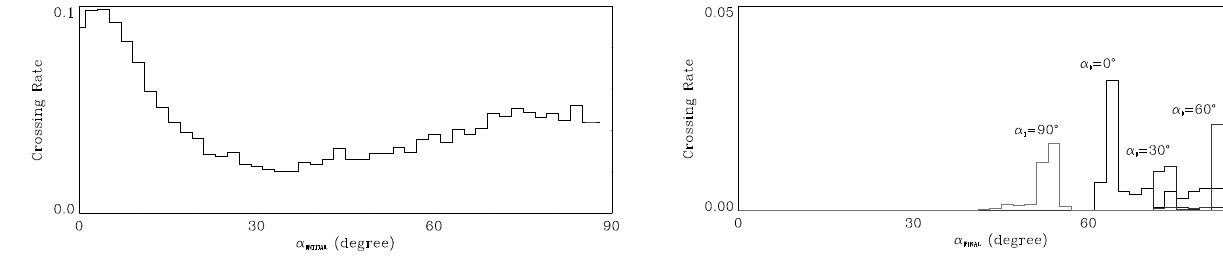
Fig. 6. Number of escaping particles depending on initial pitch- angle.